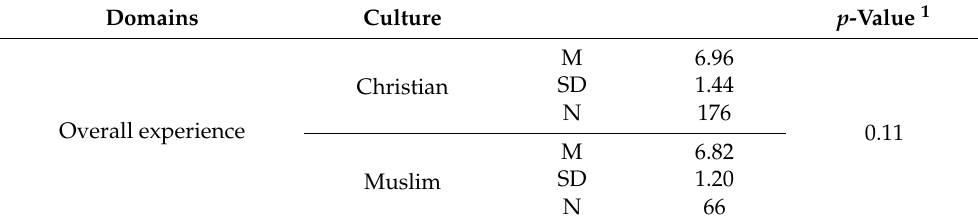
Table 3. Cont . Domains